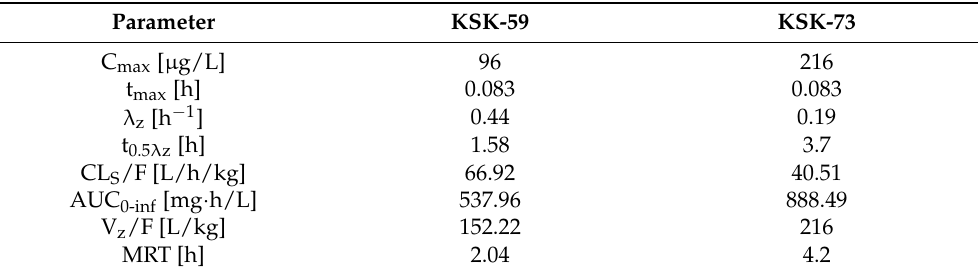
Table 3. Estimated pharmacokinetic parameters (non-compartmental analysis) of the investigated compounds calculated from the mean rat plasma concentration values ( n = 3) after single i.p. admin- istration at a dose of 10